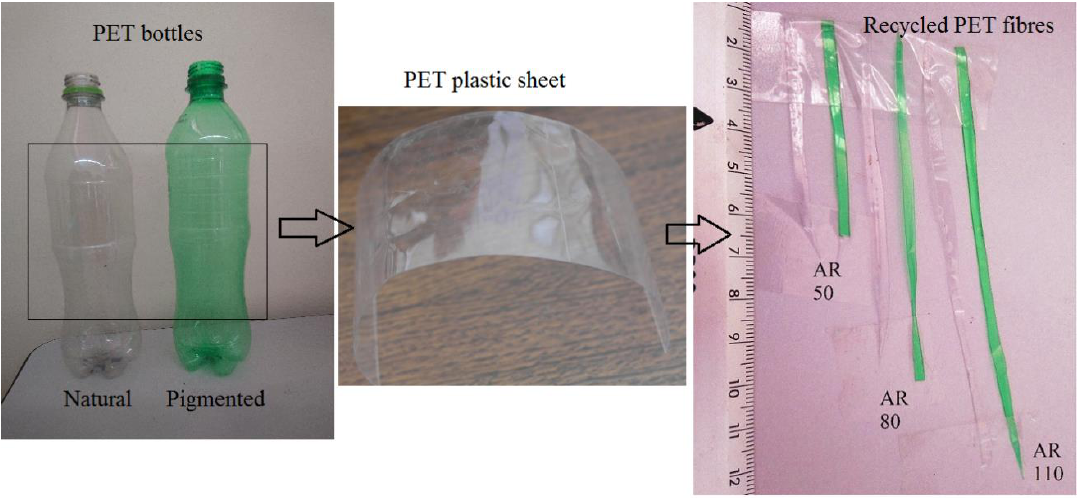
Figure 2. Procedure to generate recycled polyethylene terephthalate (PET) fibres (AR is the fibre aspect ratio).